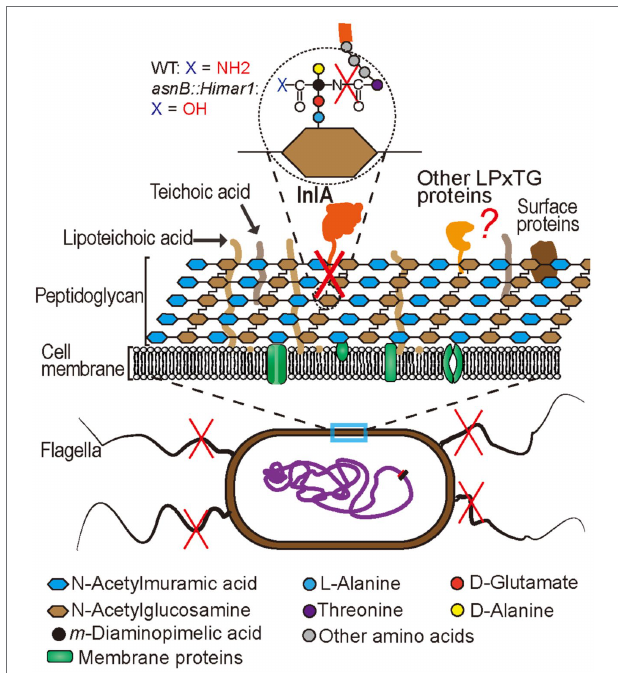
FIGURE 9 | Schematic representation of cell surface changes resulting from AsnB deficiency in L. monocytogenes . The direct effect of loss of AsnB activity is the absence of amidation of the m DAP ε -carboxyl group (shown in inset in top of the figure). Indirect consequences include inefficient InlA display at the cell surface, probably because it can no longer be cross-linked to the ε -amino group of m DAP and the loss of flagella (indicated by red cross over the structure). Other surface proteins which, like InlA, are exported and cross- linked via an LPXTG motif may also fail to be anchored to the cell surface (red question